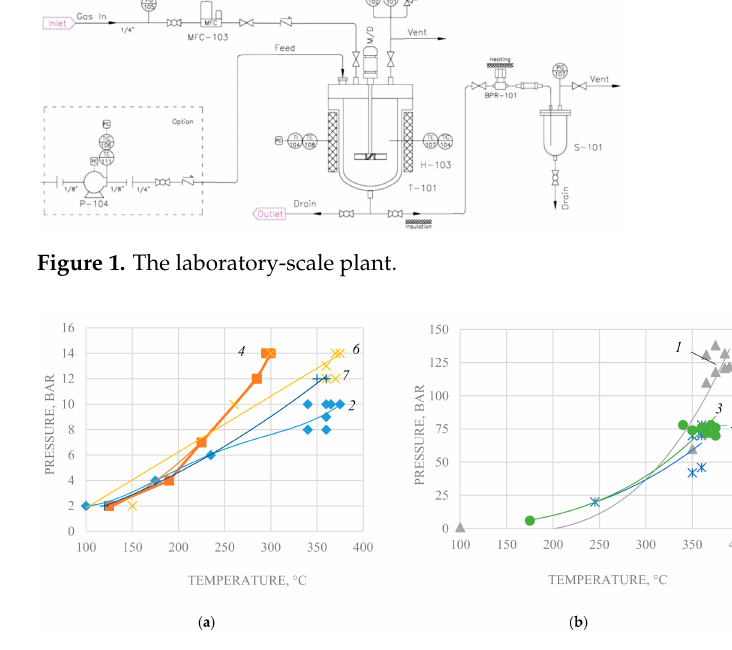
Figure 2. Hydrodynamic conditions: ( a ) experiments 2, 4, 6, 7; ( b ) experiments 1, 3,